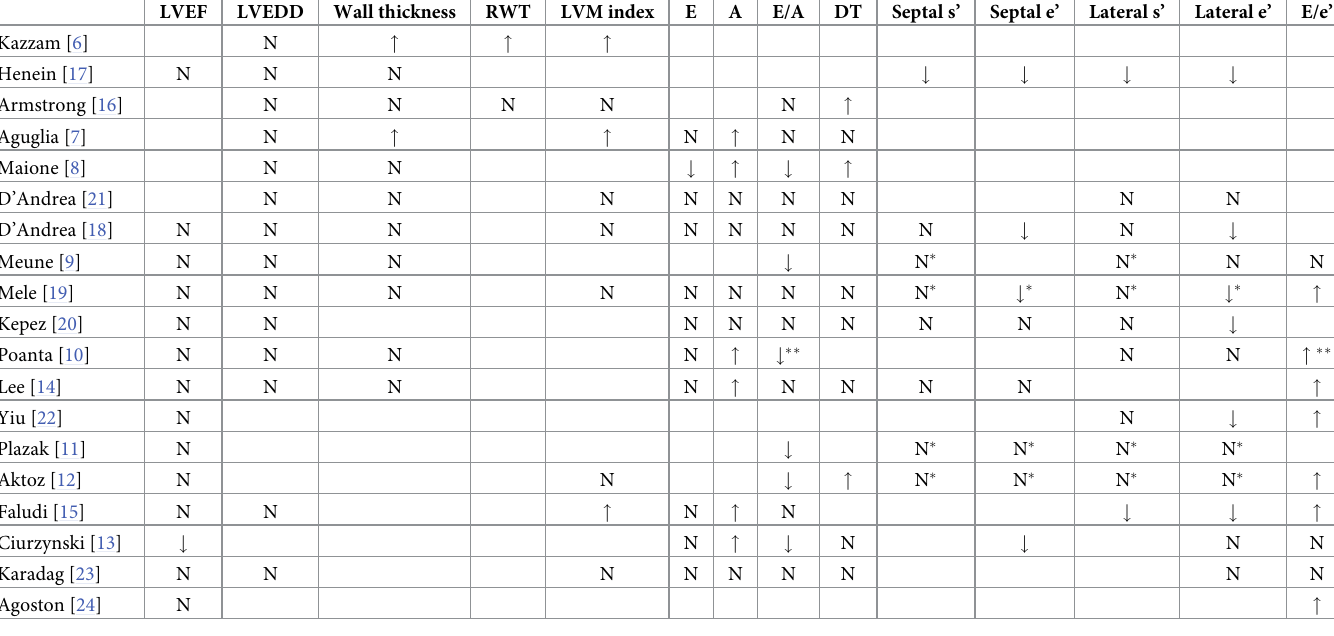
Table 7. A summary of the findings of a selection of systemic sclerosis echocardiographic studies in which LV structural or filling variables or long-axis velocities have been compared to control